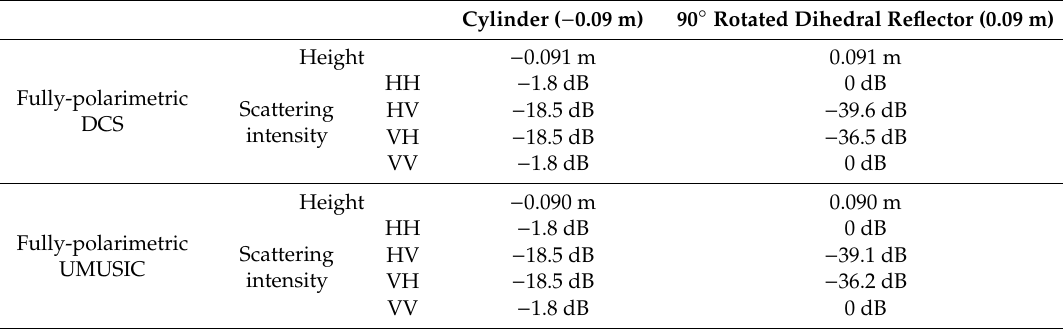
Table 1. Estimated results of two point scatterers with a spacing of 0.18